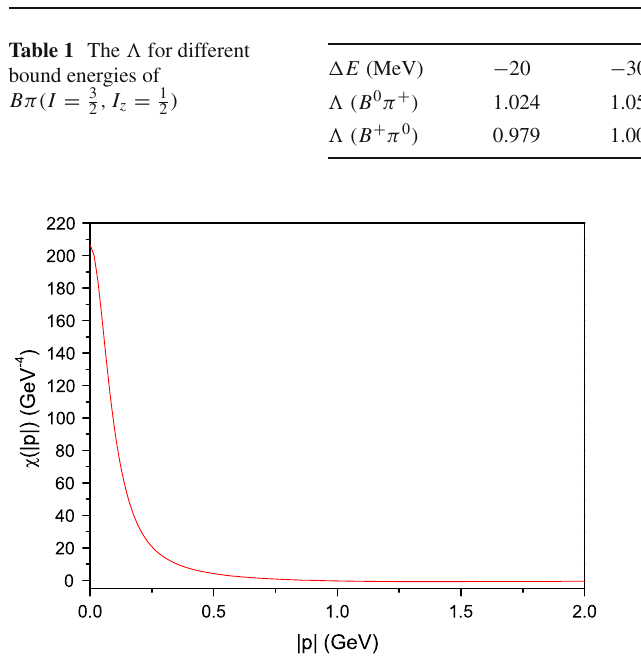
Table 2 The (cid:2) for different bound energies of B + π + ( I = 3